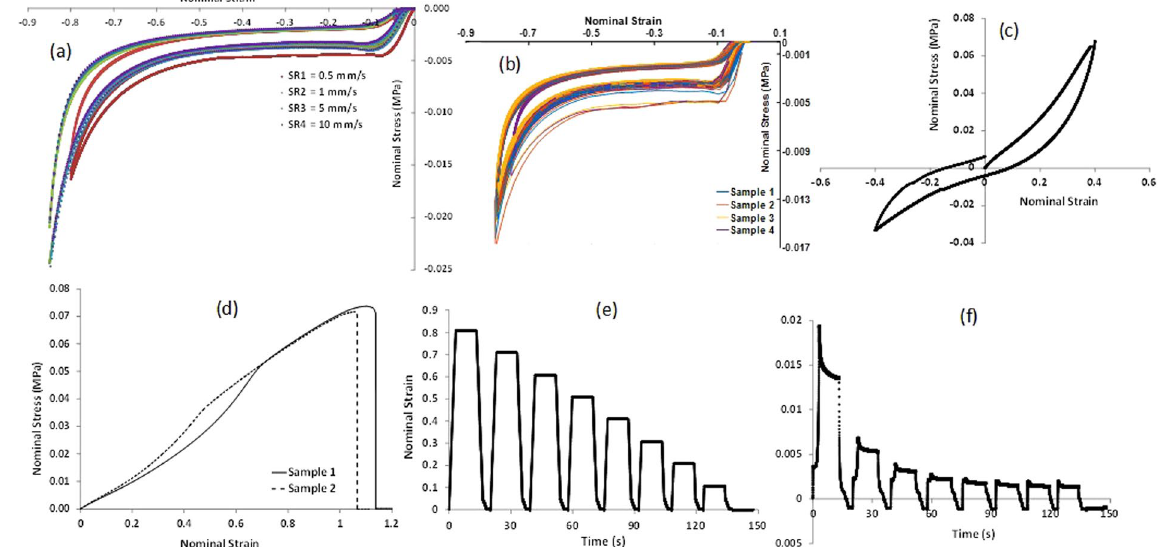
Figure 3. Stress-strain data for polyurethane foam samples undergoing mechanical testing under different modes of deformation. (a) Stress-strain data from uniaxial compression tests at different strain rates. The sample undergoes compression up to 80% of its original volume. (b) Cyclic test results in uniaxial compression. (c) Test results from simple shear testing. (d) Uniaxial tension test results. (e , f) Stress relaxation test results showing the decay of strain and stress vs. time,